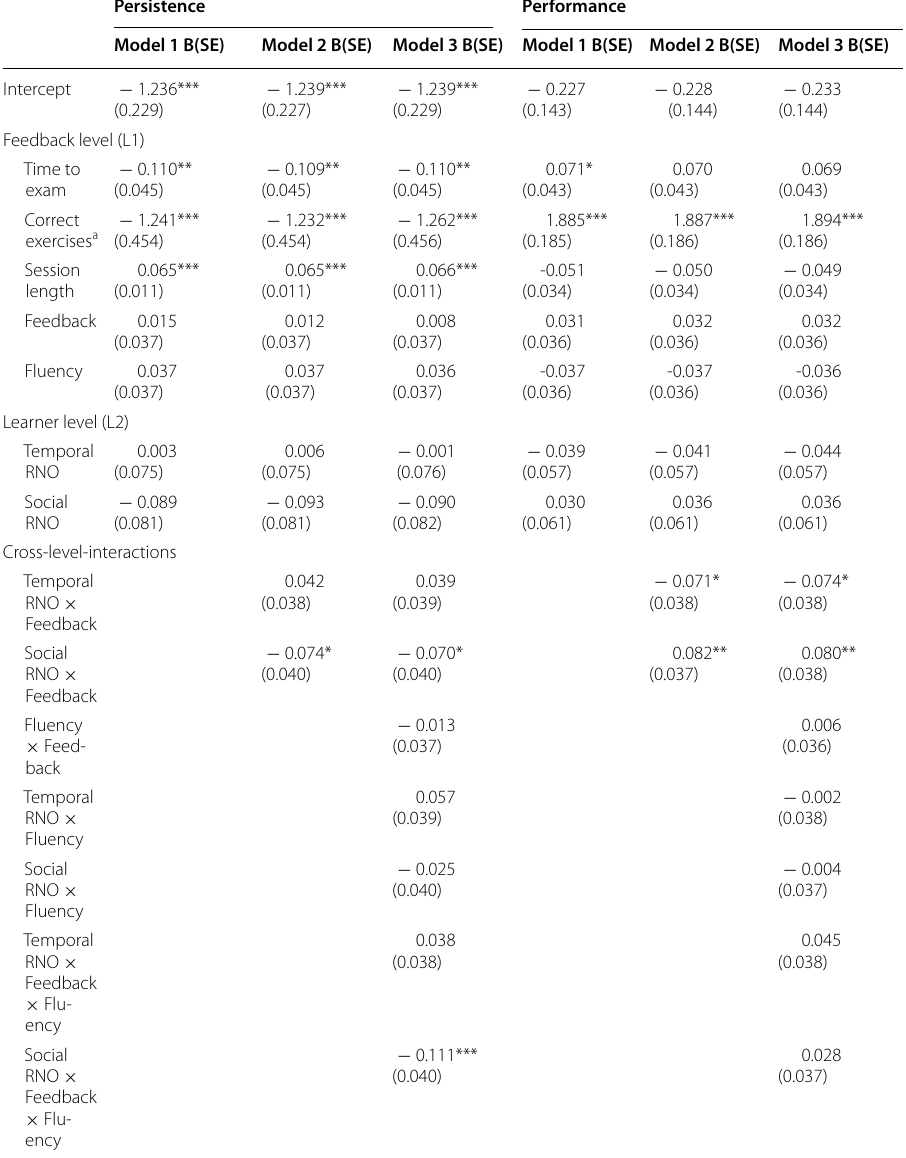
Table 3 Multilevel regression on learning persistence and performance in experiment